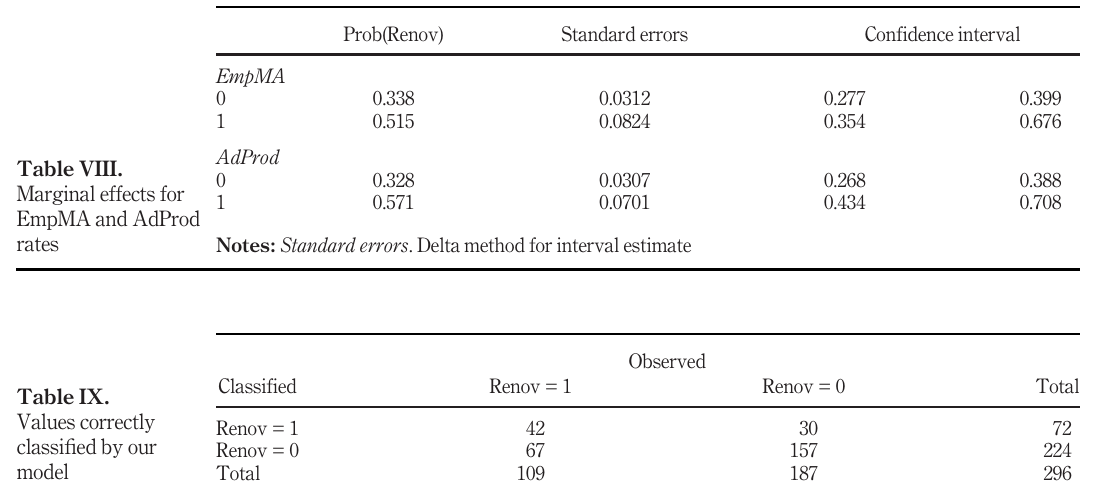
Prob(Renov) Standard errors Confidence interval EmpMA 0 0.338 AdProd 0